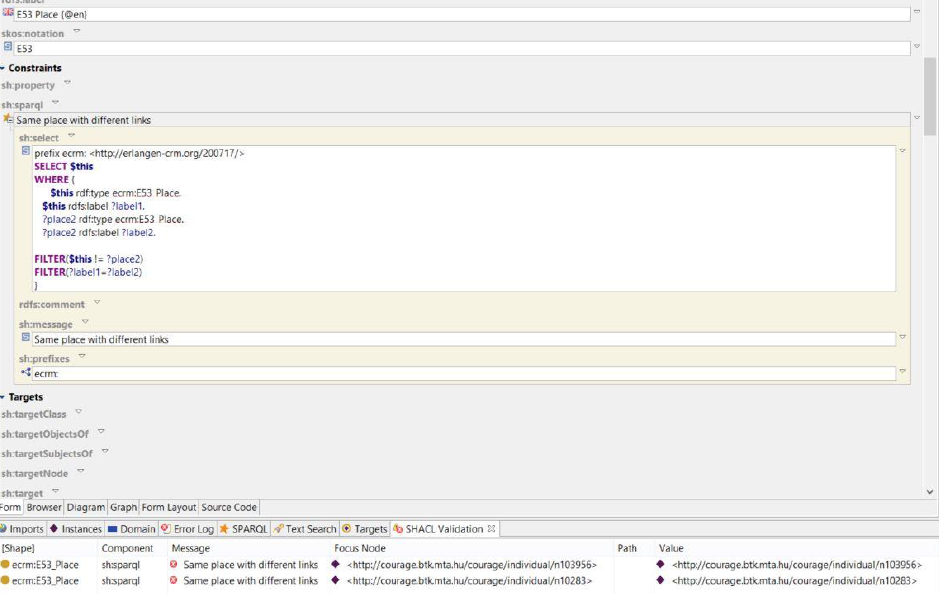
Figure 14. Validating same places with different